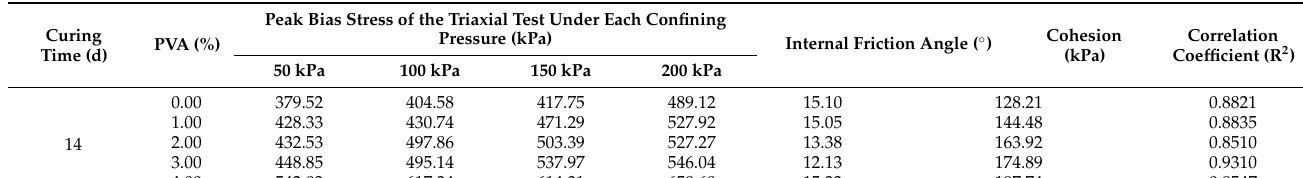
Table 2. Results of triaxial shear test of polyvinyl acetate specimens.